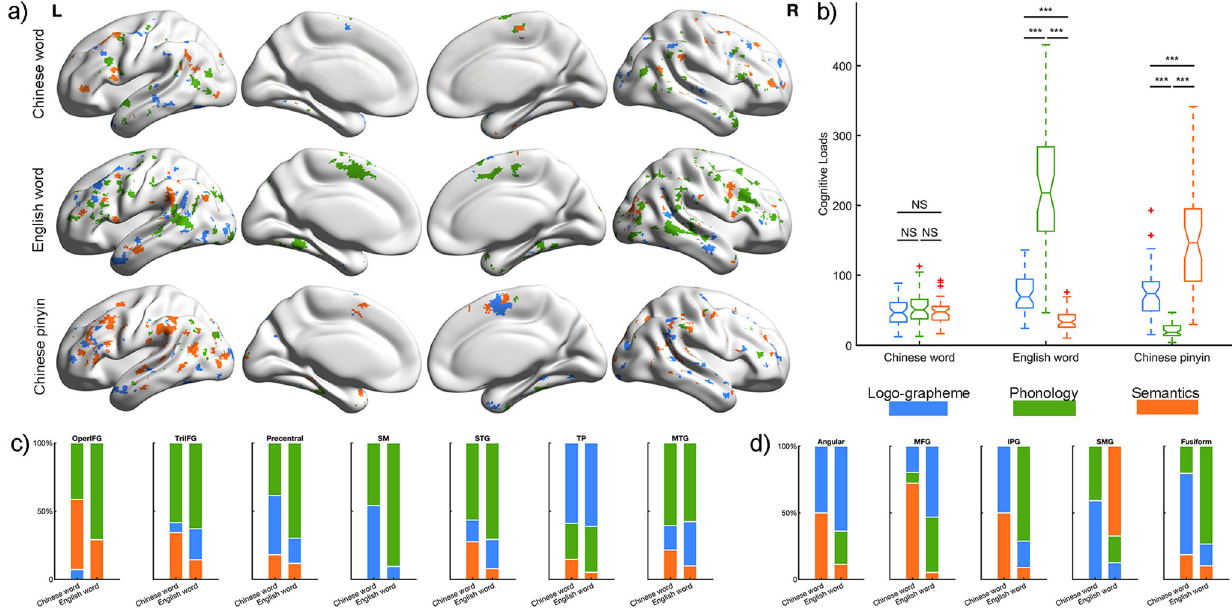
Fig. 6 Brain representations for three linguistic components. a Brain involvement maps of three linguistic components in each language type. Gray lines indicate the regional boundaries. b Two-way repeated ANOVA was performed, and signi fi cant differences were found between linguistic components and language types. Post hoc analysis shows differentiated patterns of brain activity elicited by language-processing components for English words and Chinese pinyin. *** p < 0.001; NS, non-signi fi cance. c Regions with similar patterns in percentage of cognitive loads for each linguistic component in Chinese word and English word reading. d Regions with different patterns in percentage of cognitive loads for each linguistic component in Chinese word and English word reading. Blue indicates brain activity for logo-grapheme, green represents brain activity for phonology and orange denotes brain activity for